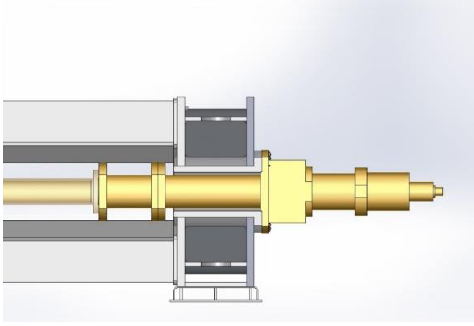
Figure 11. Combined load shaft.